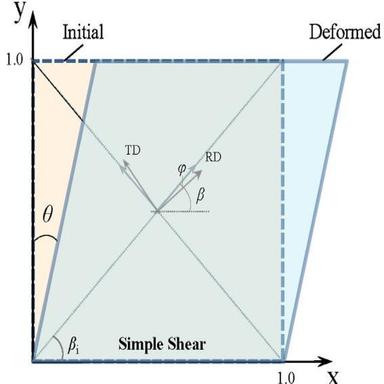
1. An element is subject to simple shear deformation. The x-y is a global (fixed) frame. The RD-TD is the material frame that has been depicted schematically to show the rotation of the material axes.